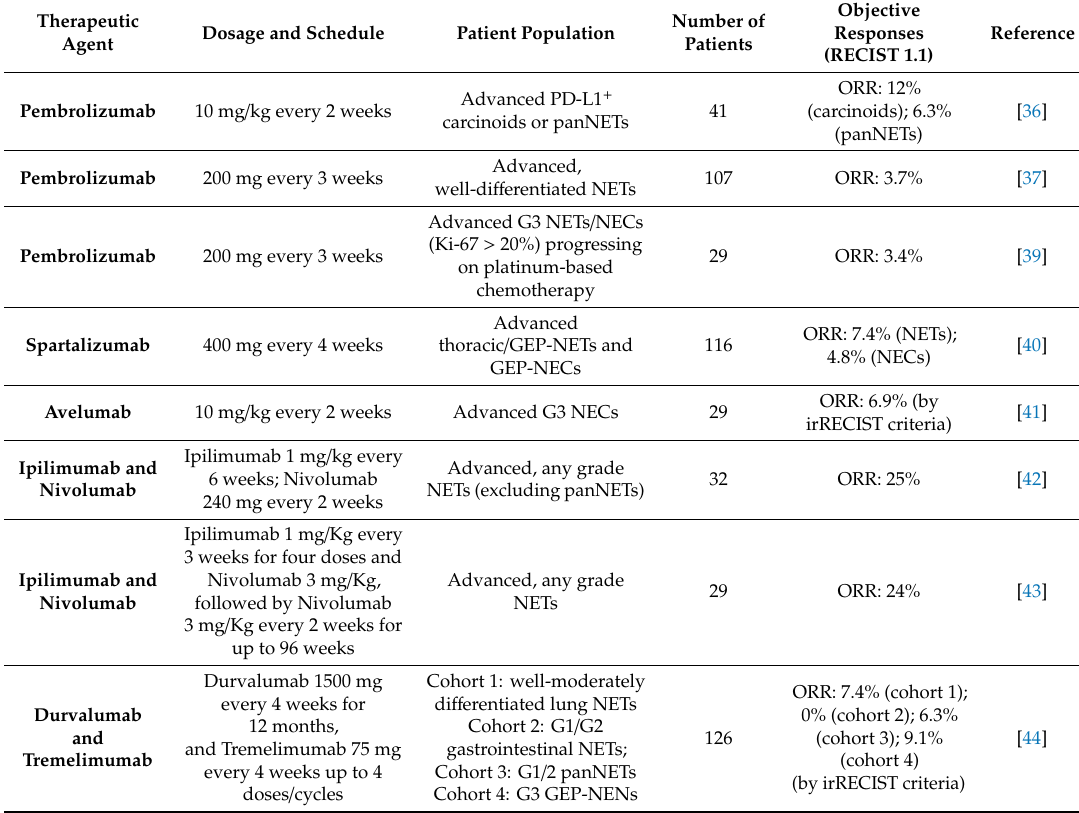
Table 3. Clinical trials of immunotherapy in patients with